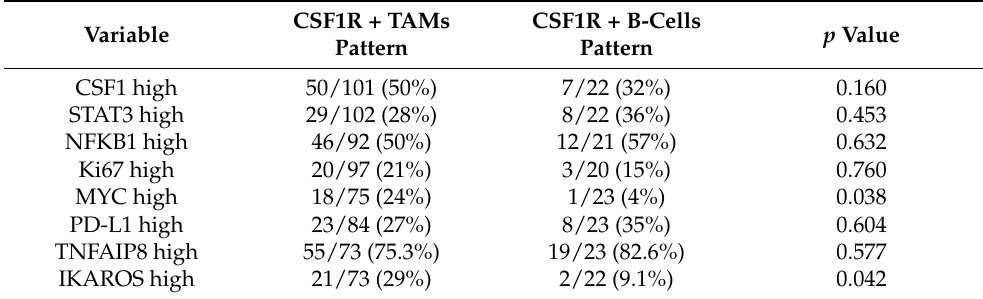
Table 5. Correlation between the histological patterns of CSF1R and the markers of the CSF1R- pathway of the samples (Tokai series).